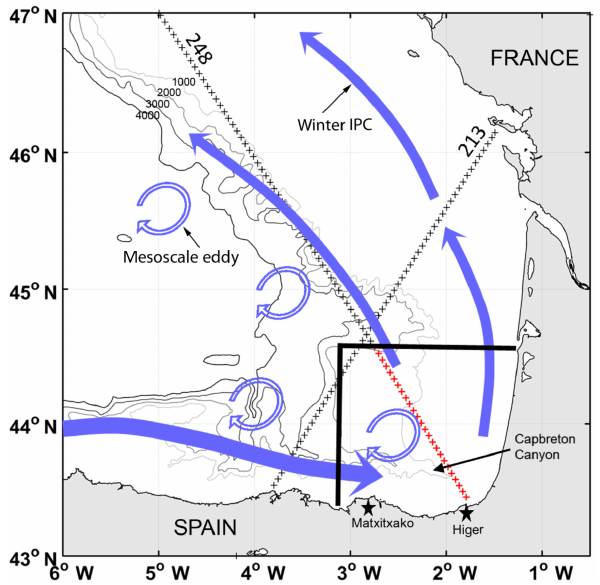
Figure 1. Study area, observational systems and main character- istics of the ocean circulation (figure modified from Rubio et al., 2018). The winter IPC is represented by blue solid arrows, whereas the blue hollow arrows show the mesoscale eddy regime (although only anticyclonic arrows are represented, eddies of anticyclonic and cyclonic polarity are observed in different locations along the slope). The bold black lines delimit the HFR total-current footprint. The black stars represent the HFR stations: Matxitxako (left) and Higer (right). Jason-2 tracks 213 and 248 are represented by black crosses and the part of the track used in this study is marked in red. Grey lines: 1000, 3000, and 4000m